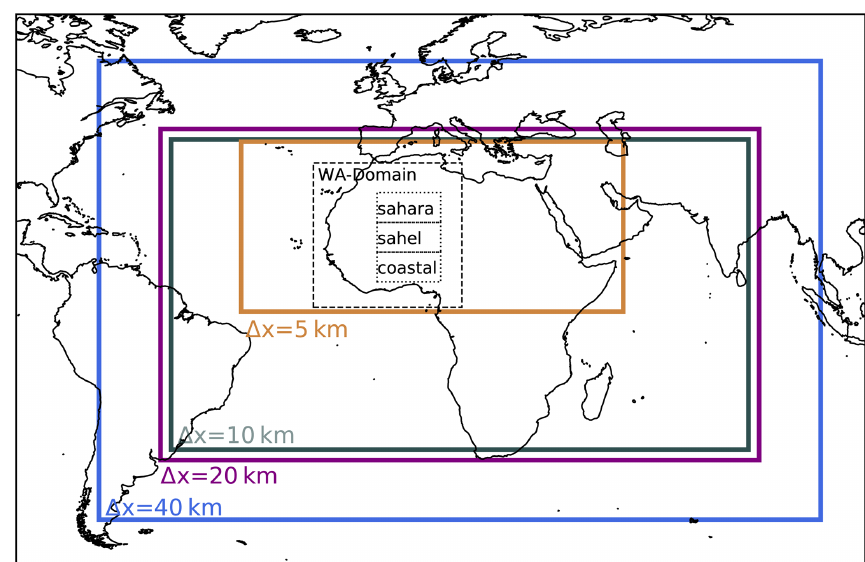
Figure 1. Colored domains display the nesting domains of the simulations for the various grid spacings (as indicated). The dashed black domain with the label “WA domain” (west Africa) shows the analysis domain for Figs. 3, 4, 6, 8, and 10 and spans the area from 1–35 ◦ N and from 20 ◦ E–15 ◦ W. The three dotted black domains over north Africa are used to calculate the skew-T diagrams for the coastal African region (“coastal”), the Sahel region (“Sahel”) and the Saharan region (“Sahara”) in Fig. 7. The coastal region spans from 6–14 ◦ N and from